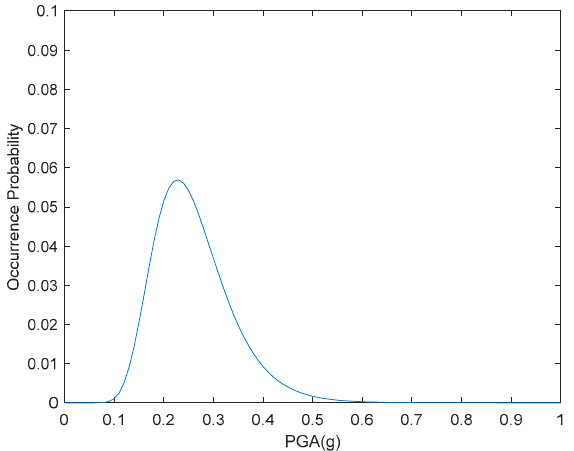
Figure 13. Occurrence probability distribution of the bridge considered having a 50 year of lifespan.